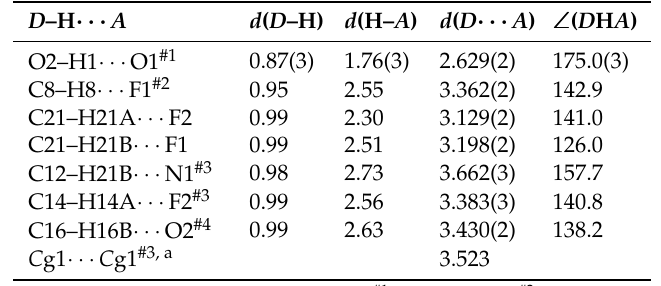
Figure 5. ( a ) Dimer formation through O–H … O hydrogen bonds between the carboxyl groups in compound 1 and additional C–H … F hydrogen bonding interactions from the cocrystallized CH 2 Cl 2 molecules; ( b ) Excerpt of the packing diagram of 1 presenting the zig-zag chain formation along the c -axis stabilized by additional C–H … O and C–H … F interactions. Table 3. Non-covalent intermolecular interactions in compound 1 (Å and deg) a .